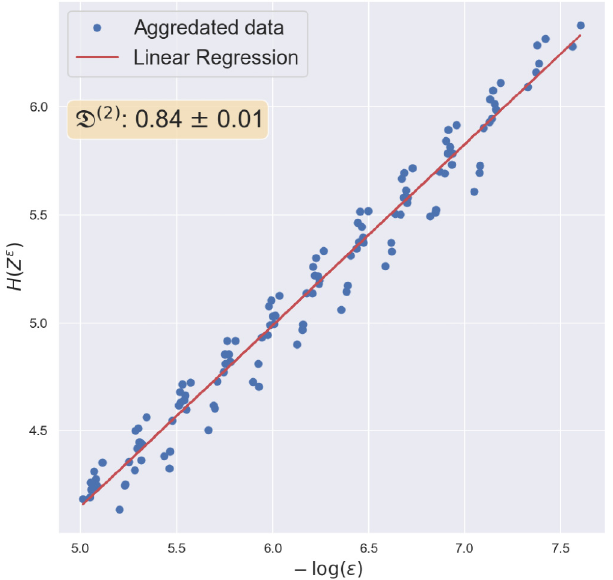
FIG. 13. Dimensional quantum entropy H [ N E ] scaling in the geometric quantum state q as a function of environment size N E . The estimated linear growth H [ N E ] ∼ 0.66 N E and so the state has entropy rate of h est = 0.66.